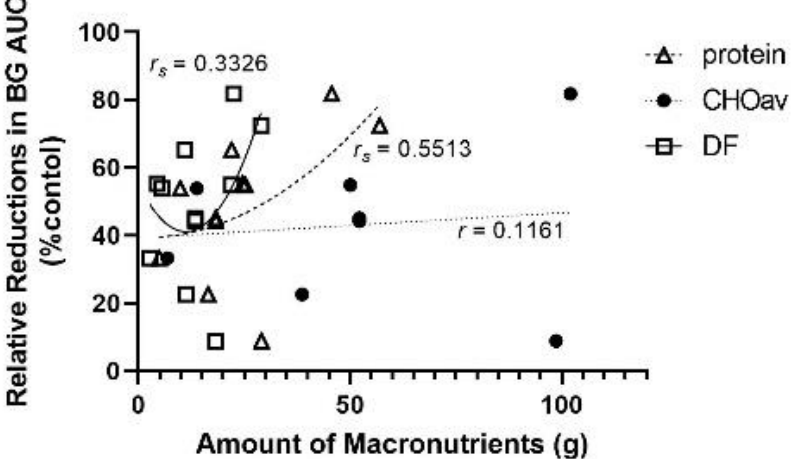
Figure 7. Relative reductions (%) of area under the blood glucose response curve (BG AUC) according to the amount of macronutrients or dietary fibre (g) in the lentil treatment group with respect to the control group. Quadratic modeling best fit protein ( r s = 0.5513; n = 11; ns ) and dietary fibre (DF; r s = 0.3326; n = 11; ns ), and a linear model best fit available carbohydrates (CHOav; r = 0.1161; n = 8; ns ).